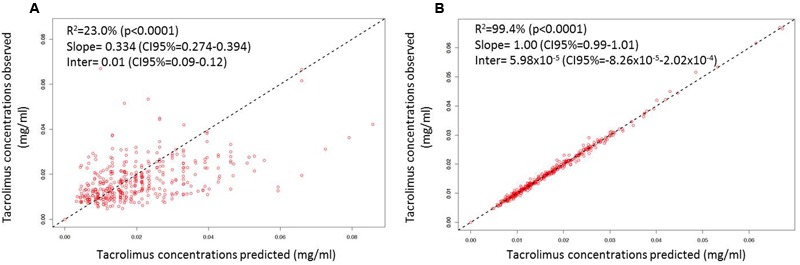
Linear regression of individual observed versus predicted Tac concentrations using (A) mean model PK parameter values and (B) the means of the individual Bayesian posterior parameter distributions. The dashed lines represent the unity lines.